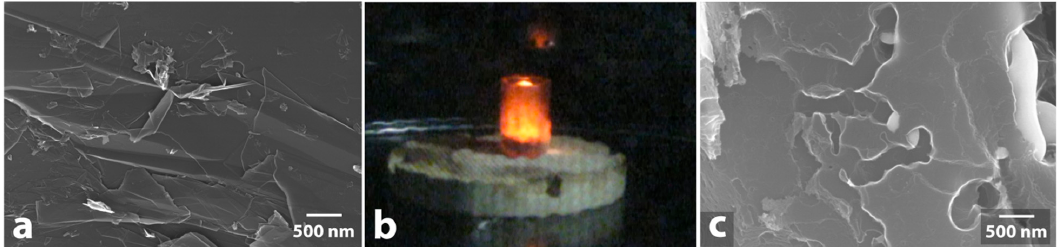
Figure 11. Effect of microwave irradiation on mixture of graphite and metal-containing compounds: initial graphite surface ( a ); microwave heating of mixture of graphite and metal compound ( b ); graphite surface with traces of etching by particles of silver ( c ).